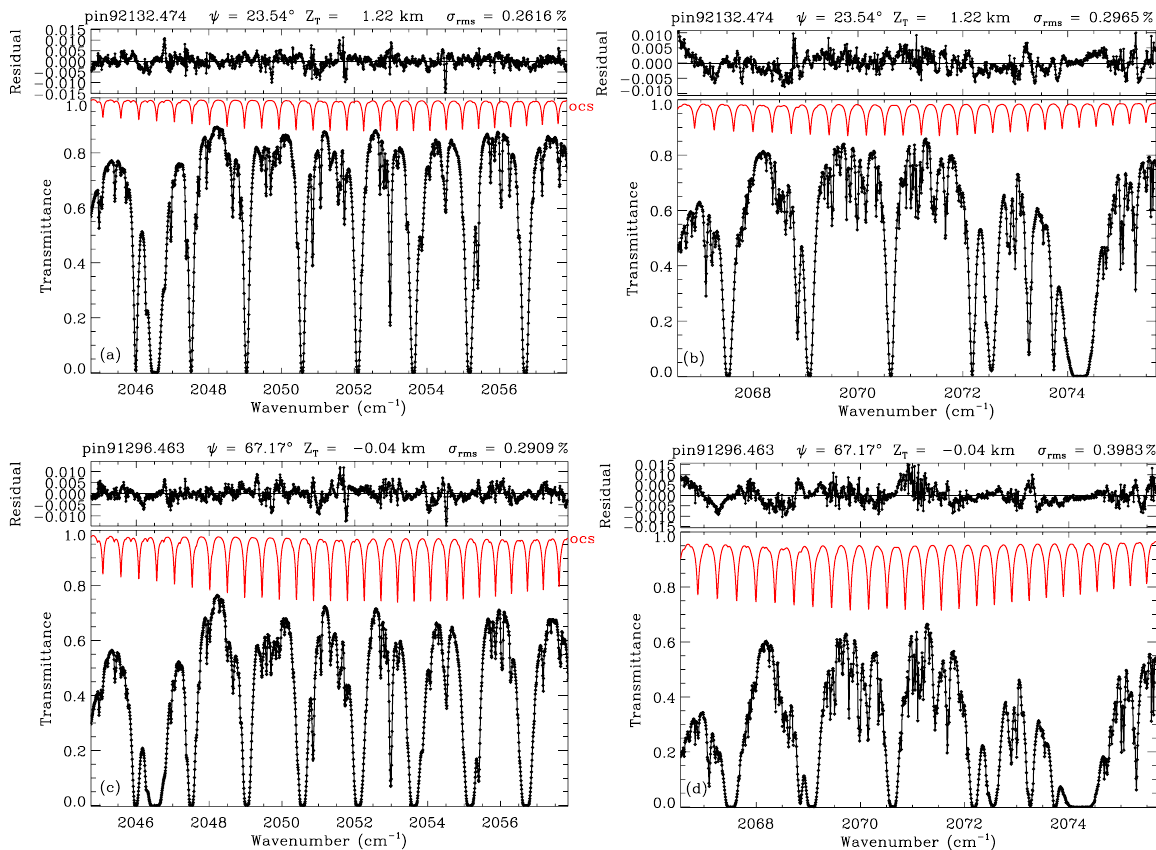
Figure 5. Examples of spectral fits to ground-based MkIV spectra. Panels a, c) show fits with the 2051cm − 1 window covering most of the P -branch of the ν 3 band. Panels (b, d) show fits to the 2071cm − 1 window covering the center of the R -branch. Panels (a, b) show fits to a low-air-mass (SZA = 24 ◦ ) spectrum. Panels (c, d) show fits to a higher air-mass spectrum (SZA = 67 ◦ ). Black symbols show the measured spectrum, and the black line is the fitted calculation. The red line is the OCS contribution to the fitted calculation. The individual contributions of other gases (mainly H 2 O, CO 2 , CO, O 3 ) are not shown because they would clutter the figure, obscuring the OCS. The saturated lines with a spacing of 1.6cm − 1 are CO 2 . Despite CO 2 being the strongest absorber, the residuals (measured–calculated) shown at the top of each panel are dominated by H 2 O and CO